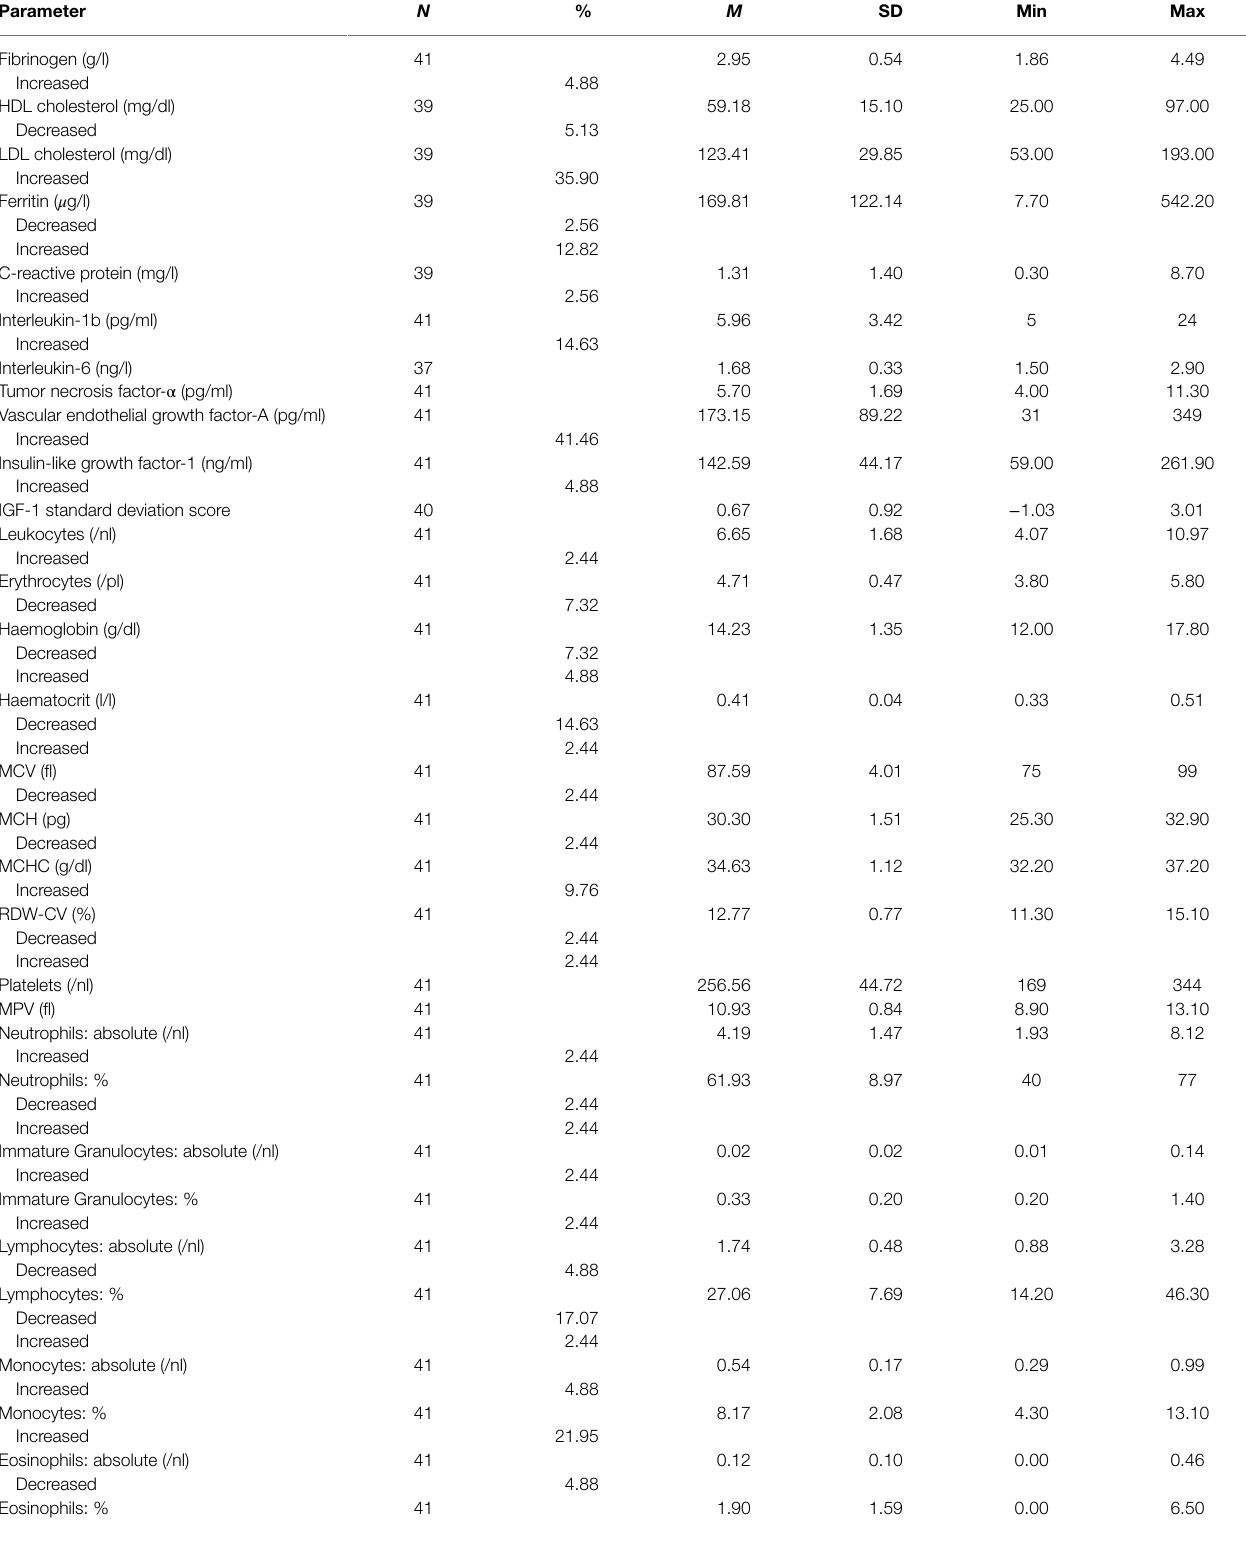
TABLE 2 | Summary statistics of blood parameters at baseline ( N = 41). Parameter N % M SD Min Max Fibrinogen